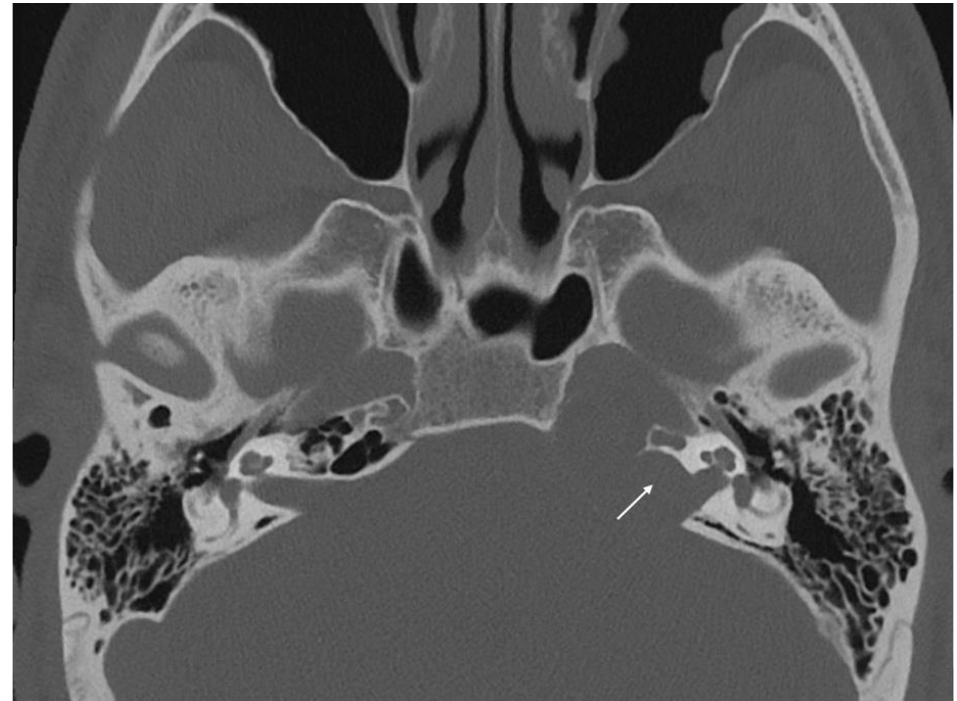
Figure 3. Axial CT scan showing erosion of the anterior wall of internal auditory canal (white arrow).